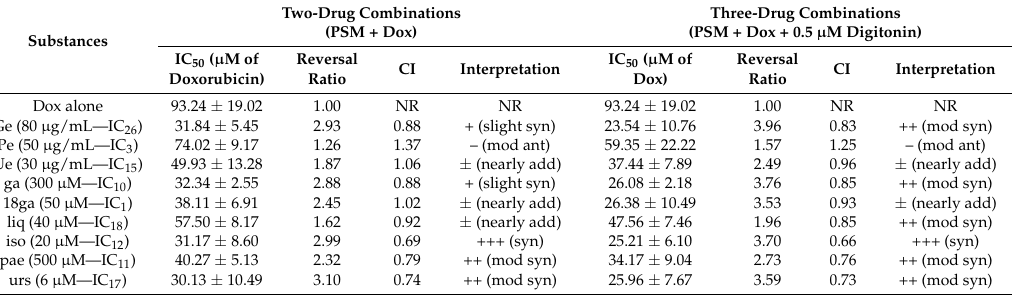
Table 3. Cytotoxicity of doxorubicin alone or in combination with a non-toxic concentration of a single substance or with a single substance plus digitonin against CEM/ADR 5000 cells. All data were from at least three independent experiments; they are represented as the mean ± SD. Ge (80 µ g/mL—IC 26 ): the concentration of Ge in combination was 80 µ g/mL and it can cause 26% of cell death in CEM/ADR 5000 cells.